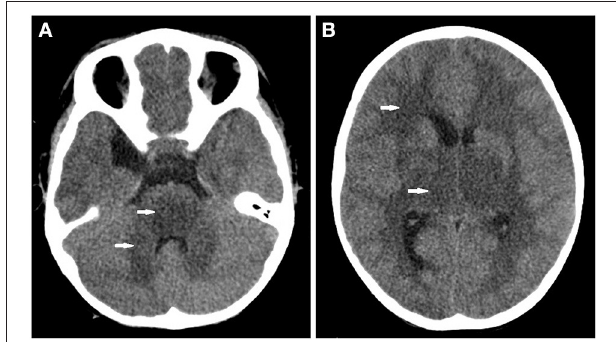
FIGURE 1 | Cranial CT found (A) extensive lesion of low intensity in the pons and cerebellum (white arrow) and (B) the bilateral white matter and thalamus (white arrow).